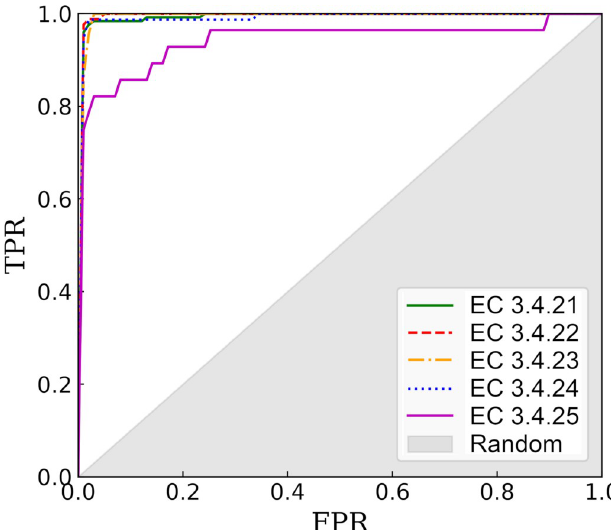
Fig 6. ROC plots evaluating the performance of DeepDrug3D against the peptidase dataset. The performance is assessed individually for five groups of enzymes, serine endopeptidases (EC 3.4.21), cysteine endopeptidases (EC 3.4.22), aspartic endopeptidases (EC 3.4.23), metalloendopeptidases (EC 3.4.24), and threonine endopeptidases (EC 3.4.25). The x -axis shows the false positive rate (FPR) and the y -axis shows the true positive rate (TPR). The gray area represents a random prediction.